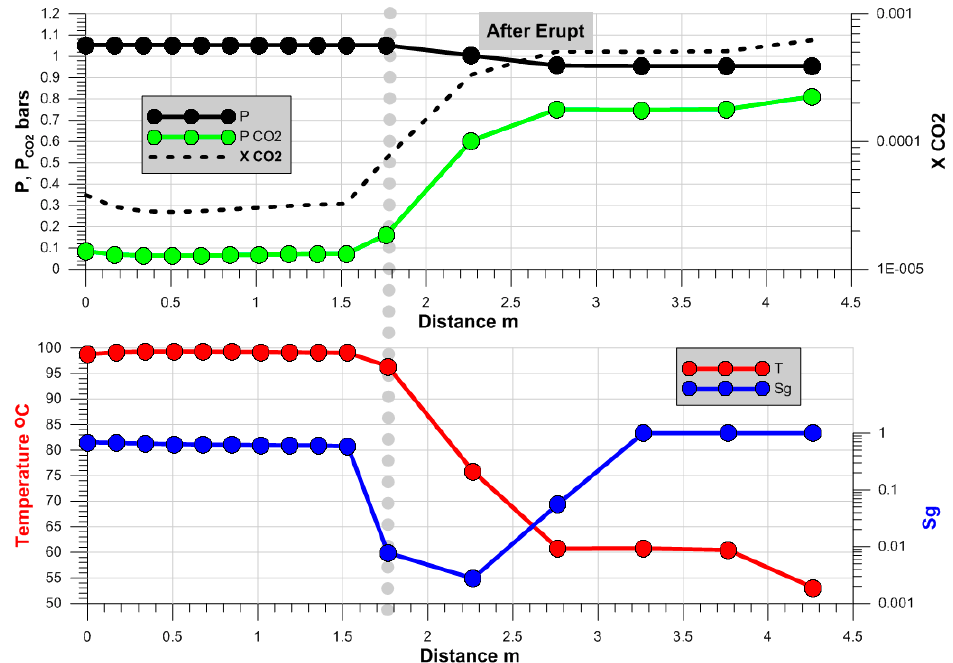
Figure 13. State before eruption (run #9A2): model parameter distributions (temperature in °C, gas saturation Sg, pressure and partial CO 2 pressure P CO2 in bars, mass fraction of CO 2 in a liquid phase) along a streamline from hot water recharge element #11 to discharge element #56 of the model (see Figure 7 for model element names references). Vertical dotted line corresponds to the position of flow direction change from radial-horizontal to ascending-vertical. Geosciences 2019 , 9 , x FOR PEER REVIEW